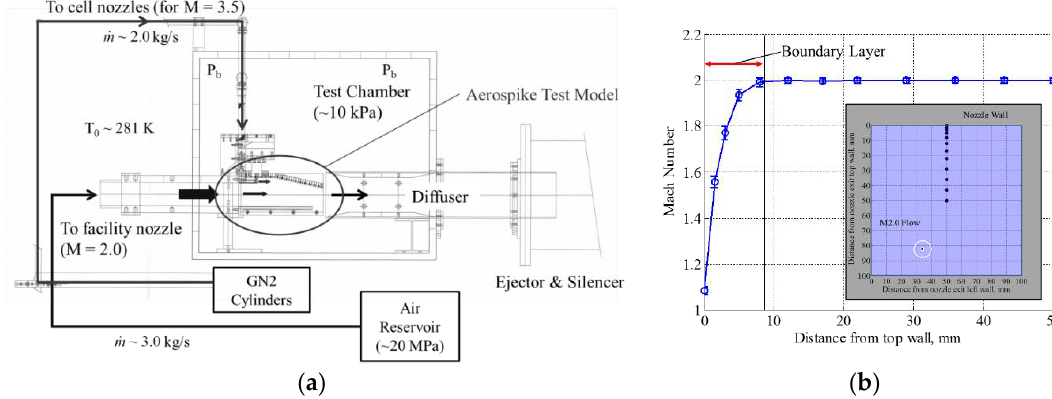
Figure 1. ( a ) Schematic of wind tunnel facility; and ( b ) Mach number profile measured at center plane of M2.0 facility-nozzle exit.